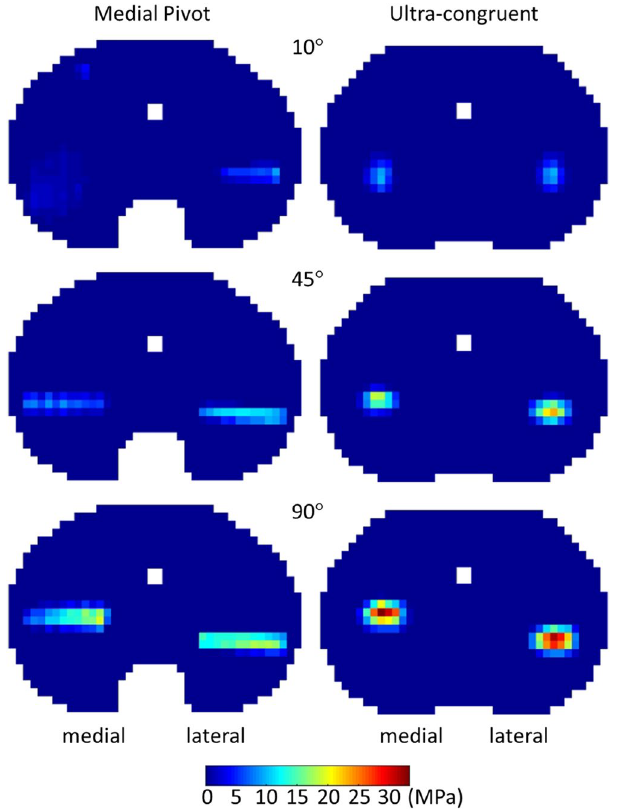
Figure 6. Pressure distribution on the insert surface at three successive flexion angles (10°, 45° and 90°) during the squat